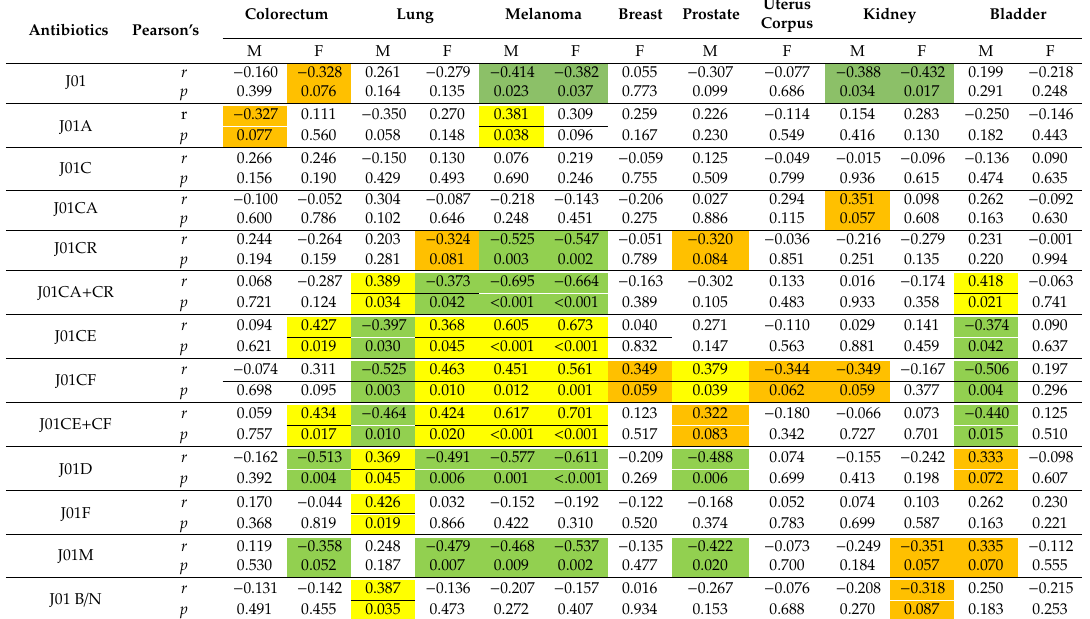
Table 9. Summary of correlation and significance (Pearson’s) between antibiotic consumption and major types of cancers (male, female). Positive significance: marked with yellow filling color, negative significance: marked with green, statistically insignificant (positive, negative, p = 0.05–0.09) marked with orange filling